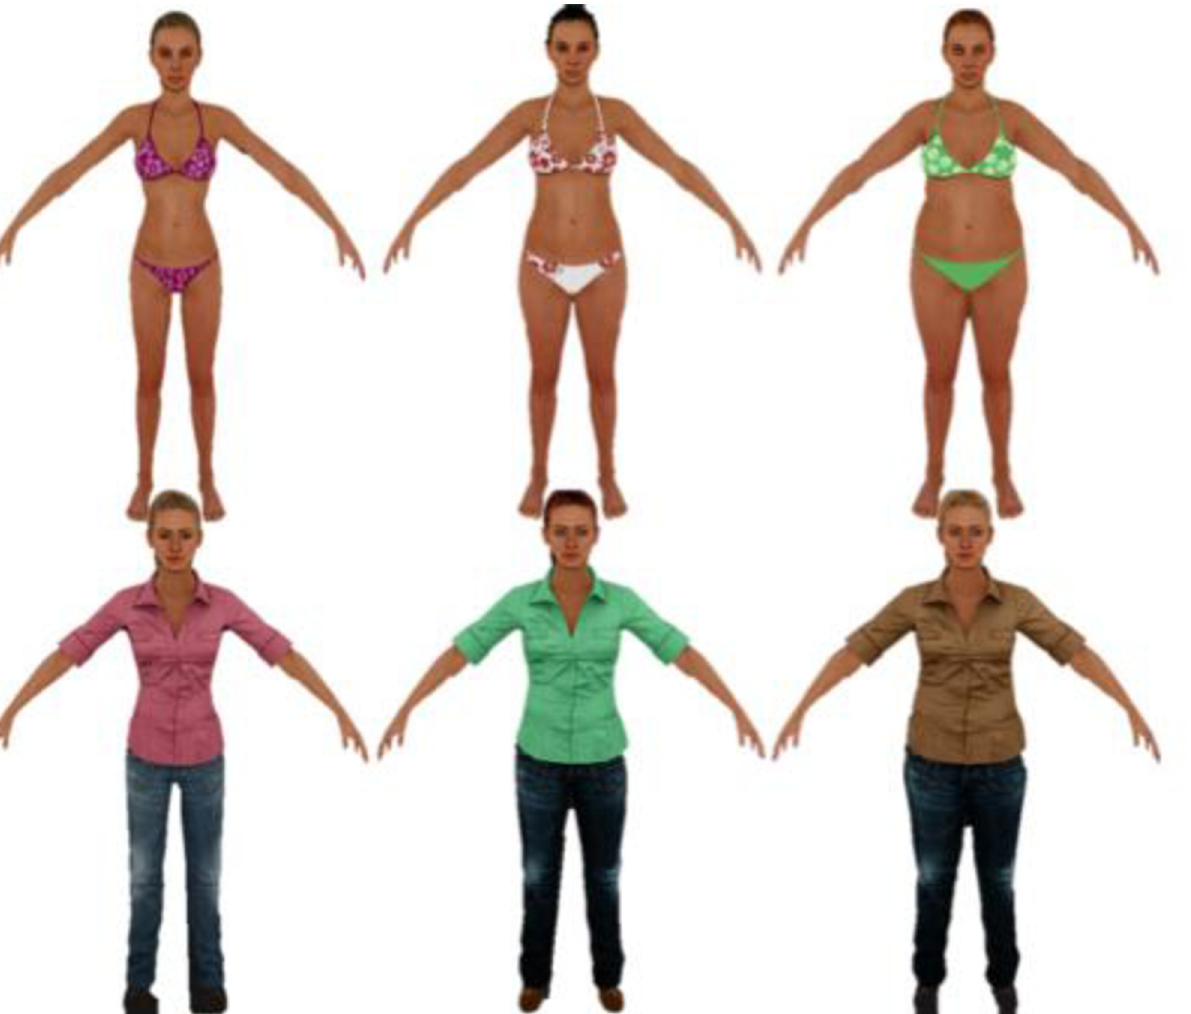
Fig 1. Female avatars from beach and party environments representing thin (BMI = 18), average (BMI = 23) and overweight (BMI = 28) from left to right.